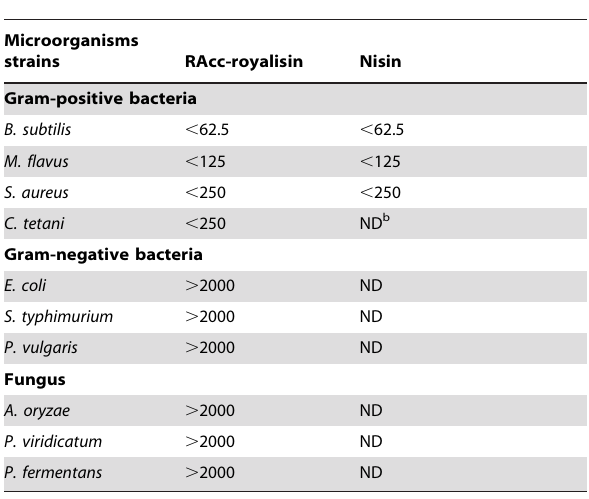
Table 2. Minimum inhibition concentrations ( m g/ml; MIC a ) at 24 h for RAcc-royalisin and nisin on different microorganism strains.